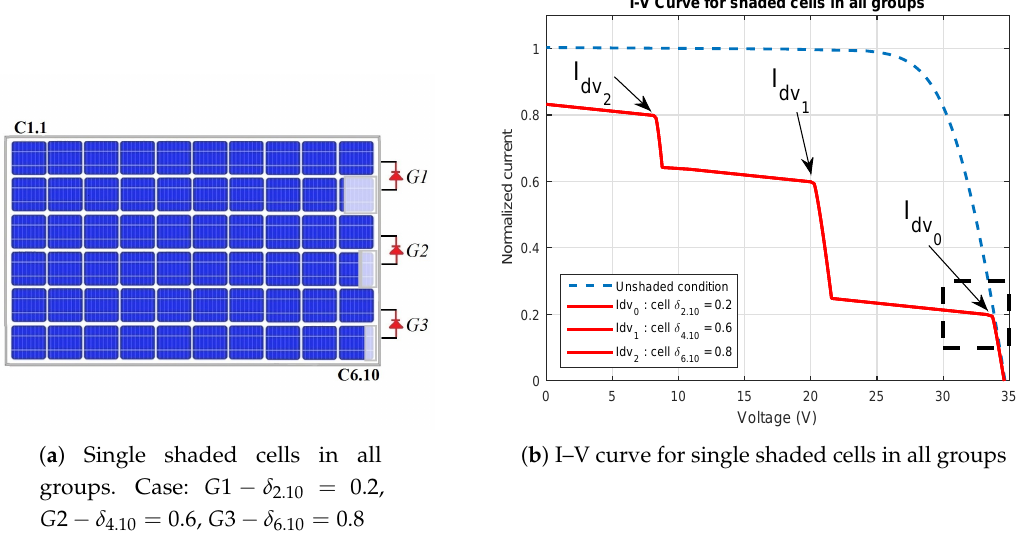
Figure 9. Study case of shadow pattern for single shaded cells in all